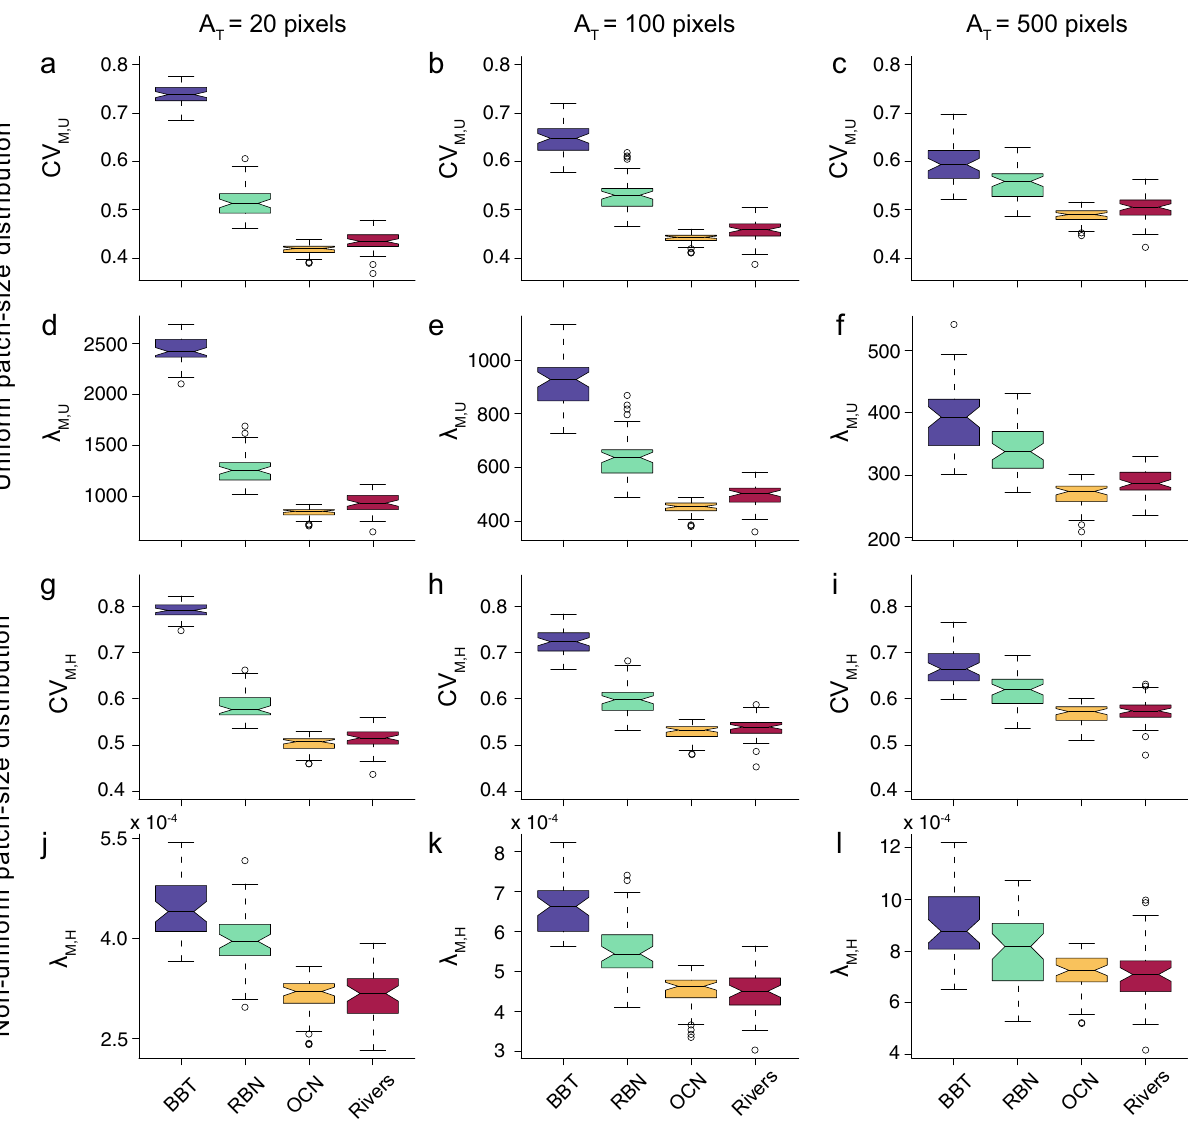
Fig. 6 Comparison of values of metapopulation metrics across river network types and observational scales ( A T ). a – c CV M , U . d – f λ M , U . g – i CV M , H . ffiffiffiffiffiffi p 50 , where IQR is the interquartile range; box limits, upper and lower j – l λ M , H . Boxplot elements are as follows: center line, median; notches, ± 1 : 58 (cid:1) IQR = quartiles; whiskers, extending up to the most extreme data points that are within ±1.5 ⋅ IQR; circles, outliers. Metapopulation metric values were obtained by setting α = 100 l . Note that in Eq. (1), given A = 40, 000, A T = 20 results in E [ N ] ≈ 4574, E [ p r ] ≈ 0.228; A T = 100 yields E [ N ] ≈ 2231, E [ p r ] ≈ 0.098; A = 500 results in E [ N ] ≈ 1088, E [ p ≈ T r ]